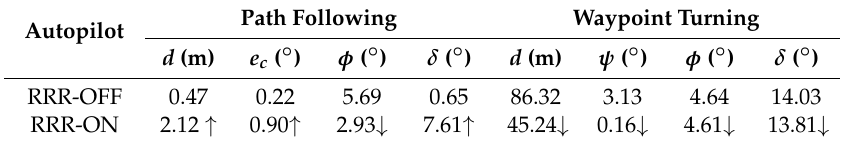
Table 1. The standard deviation (STD) values of the control performances with the RRR on/off. Path Following Waypoint Turning Autopilot